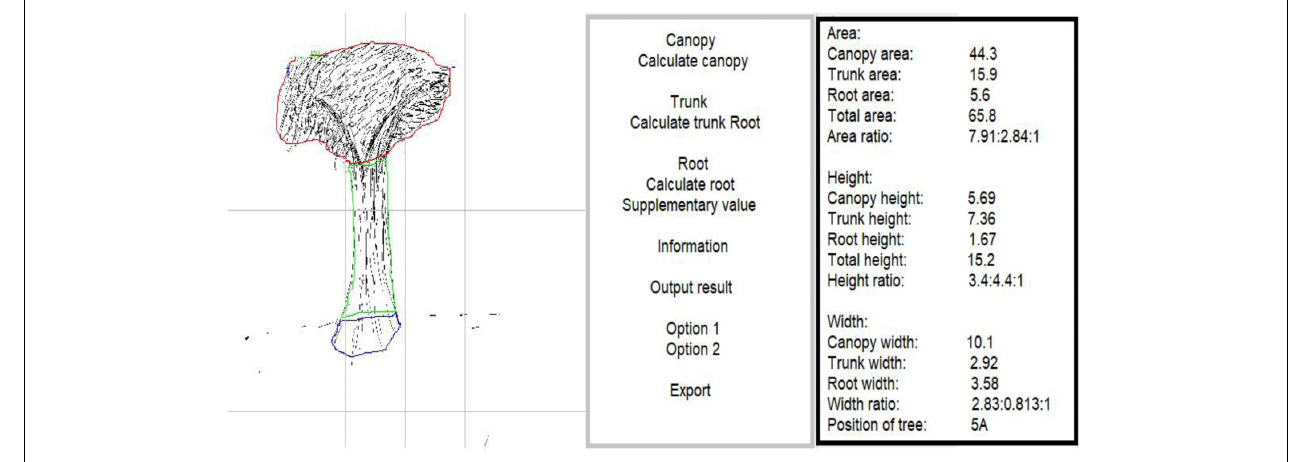
FIGURE 2 | Example of scanned tree in major depression group.